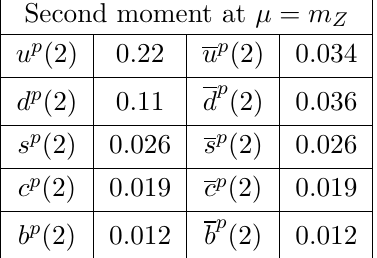
Table 5 . Numerical values of the second moments for quark distribution functions for proton. These values are evaluated at the scale (cid:22) = m Z by using the CTEQ PDFs [37]. The values for neutron are given by exchanging up and down quarks in the